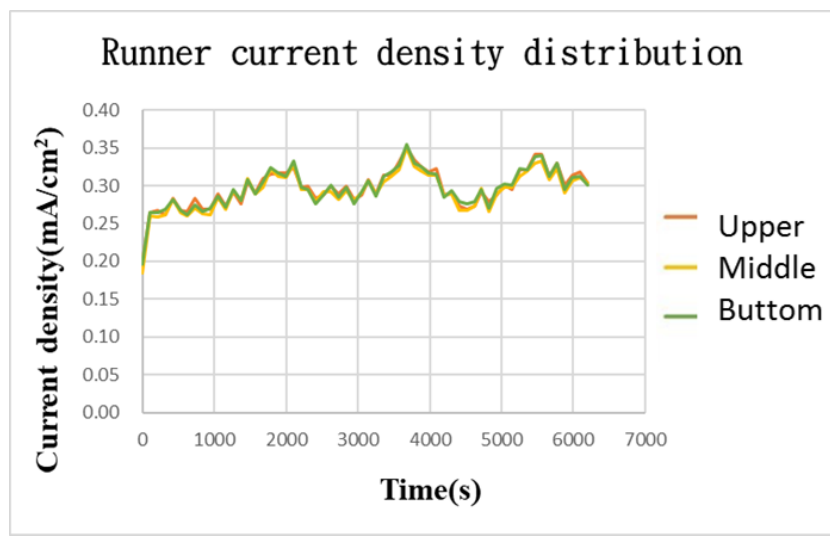
Figure 14. Runner voltage curve.